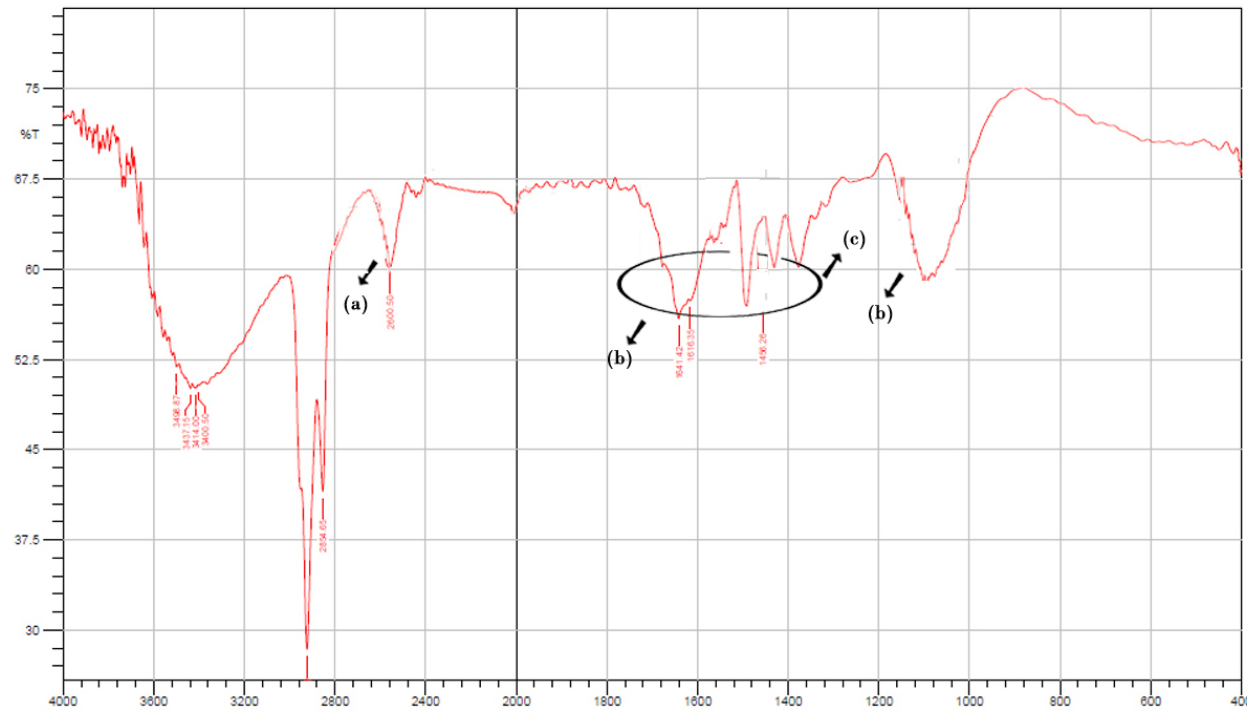
Figure 1. FTIR spectrum of STO ( a ) thiol functionalization of OG, ( b,c ) S-protected thiomers exhibiting wide peaks between 1650 and 1450 cm − 1 due to − C = C stretch vibrations ( d ) C-H wagging between thiomer and aromatic ligand.